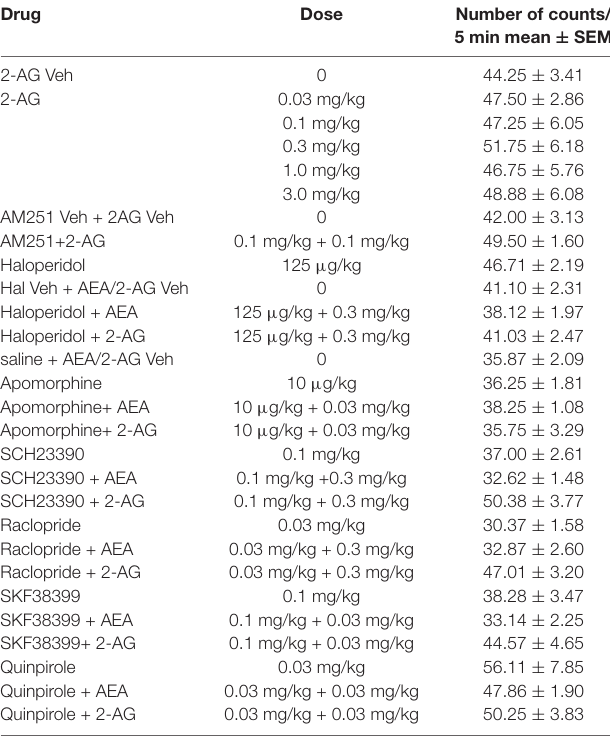
TABLE 3 | Effect of the different drug treatments on spontaneous locomotor activity of sexually exhausted male rats.